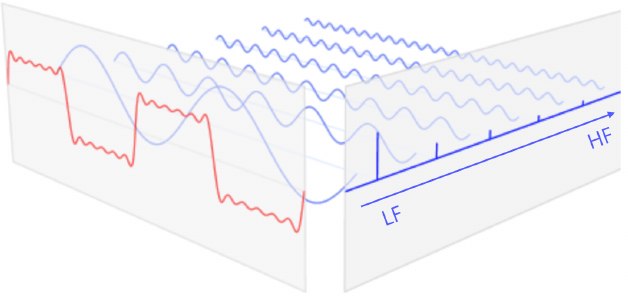
Figure 7. Original signal (red) and periodic functions (blue) composed of the weighted